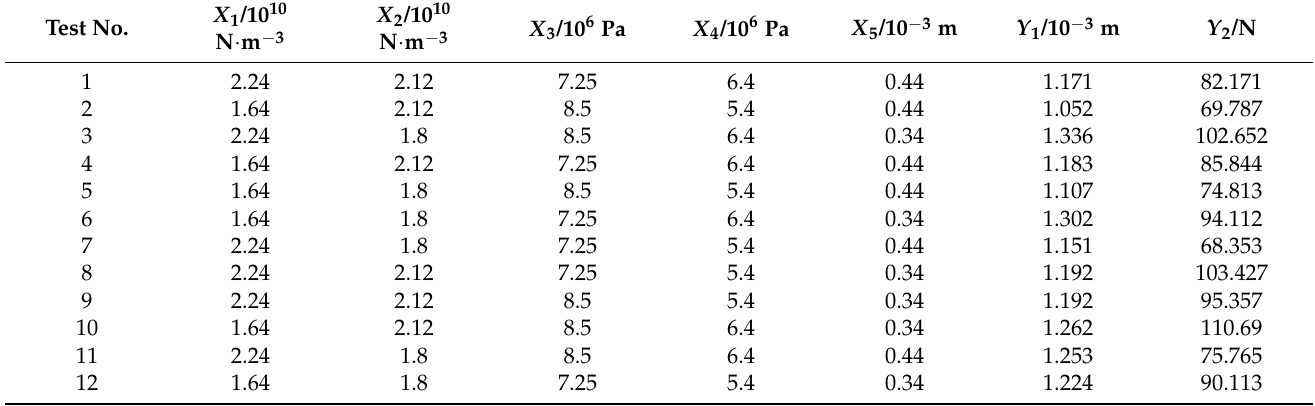
Table 7. Plackett–Burman Test